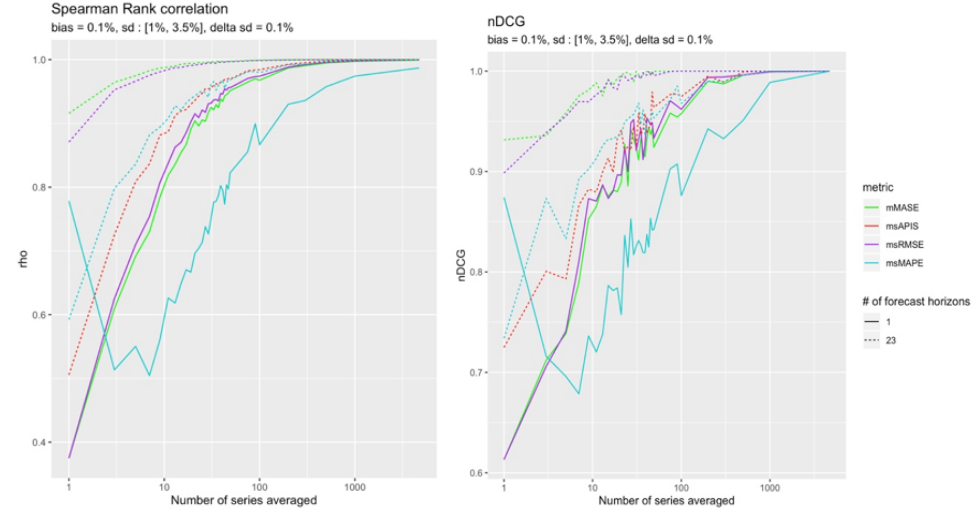
Figure 13. Spearman Rank correlation and nDCG for ( + − + ) configuration.